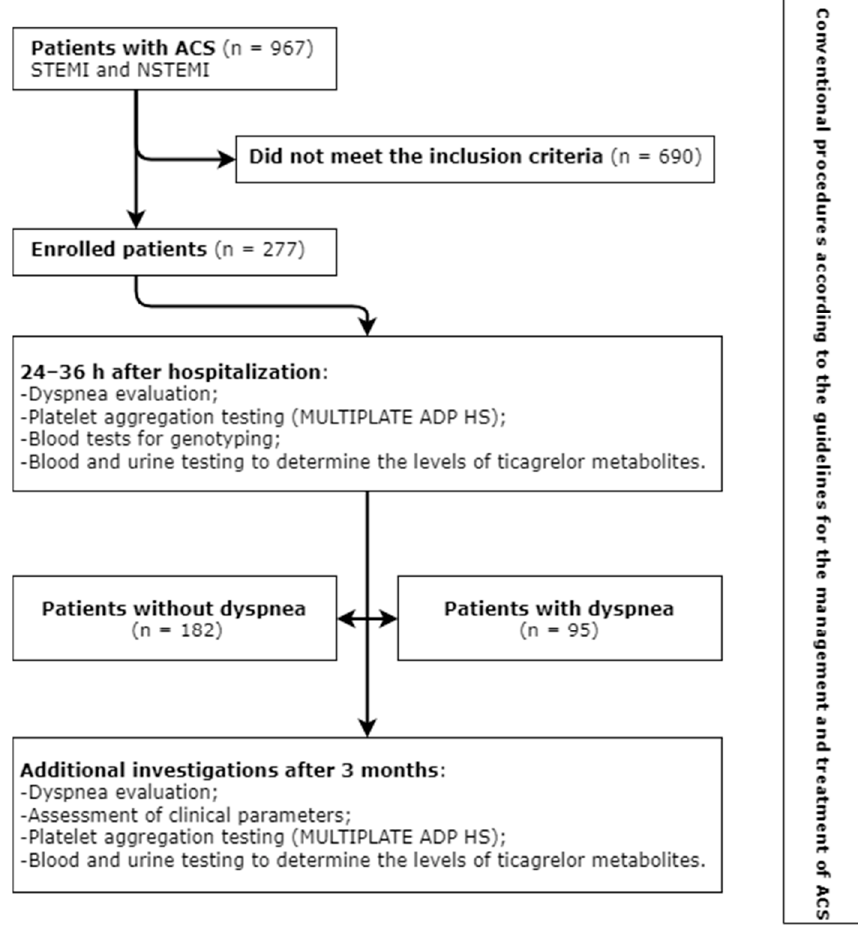
Figure 2. Study flow chart.